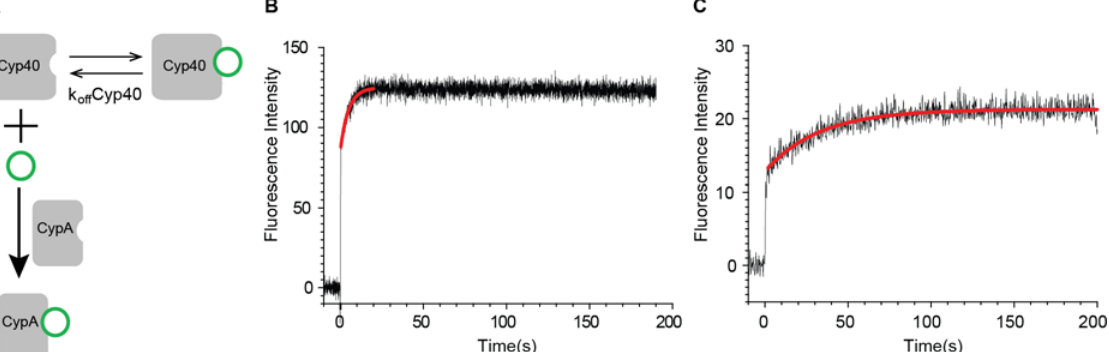
Fig 3. Probing the transient structure of CsA during dissociation from cyclophilin. ( A ) Scheme for measuring the transient structure of CsA during dissociation from Cyp40. ( B ) Fluorescence intensity time course of Cyp18 upon binding to CsA during its dissociation from the Cyp40/CsA complex. The curve was plotted after subtraction of the initial fluorescence intensity of Cyp40. One equivalent of Cyp18 was injected through stopped flow. The time course is fitted to a first-order reaction ( k = 0.205 s -1 ). ( C ) Fluorescence intensity time course of Cyp18 upon binding to the dissociated CsA from Cyp40. The Cyp40/ CsA complex was incubated with a CsA resin to remove the dissociated Cyp40 in solution. After incubating the supernatant at room temperature for half hour, Cyp18 was added and the fluorescent time course was recorded. The k obs value of 0.03067 s -1 of the second slow phase is 7 times slower than the single phase kinetics in